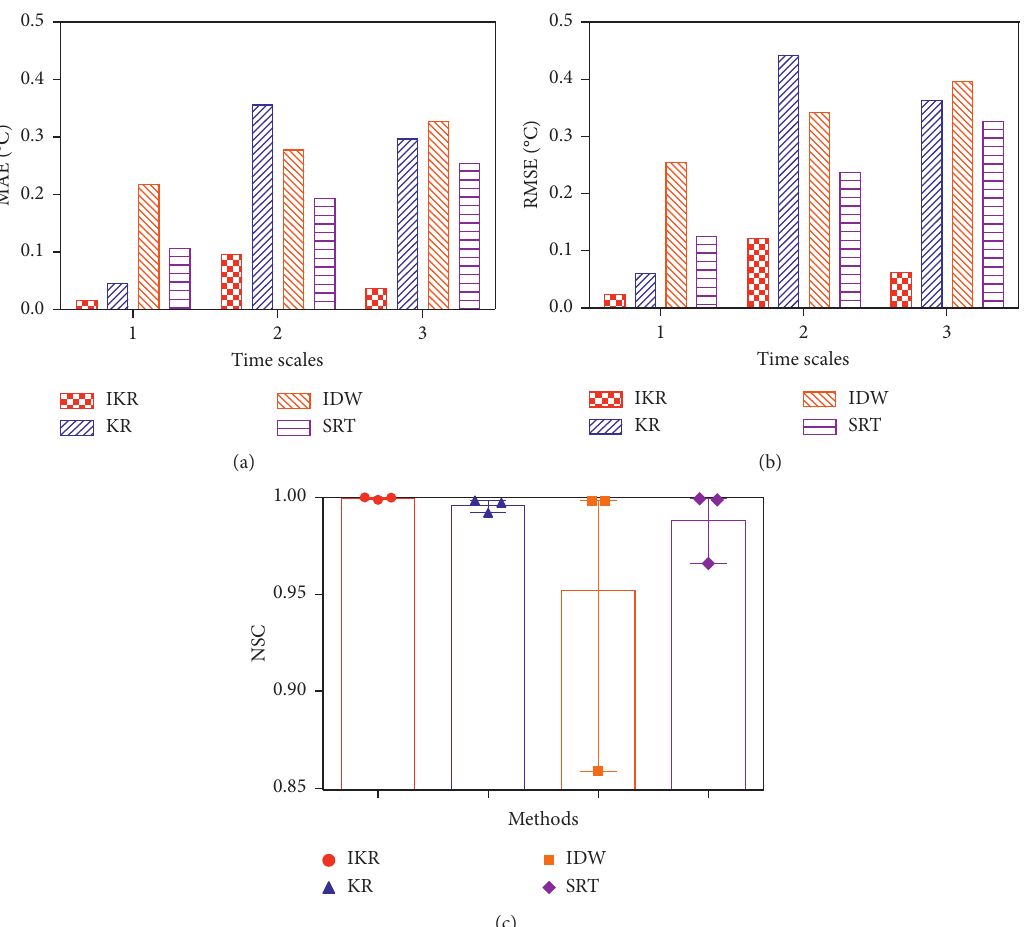
Figure 6: Comparison of the indicators of the four methods on different time scales in the Jiangsu multistation kernel regression ex- periment: (a) MAE; (b) RMSE; (c)